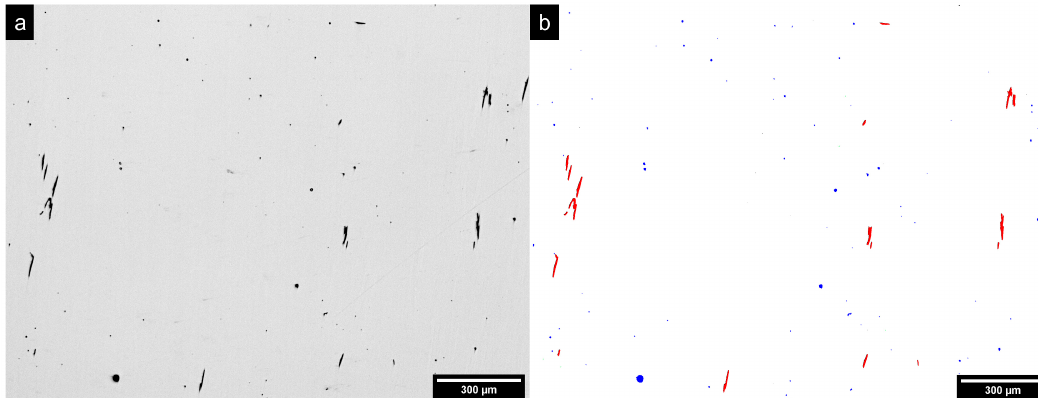
Figure 6. Example of ( a ) an original metallographic image taken with the optical microscope and ( b ) the resulting output from the algorithm. Cracks are filled with red and pores with blue.